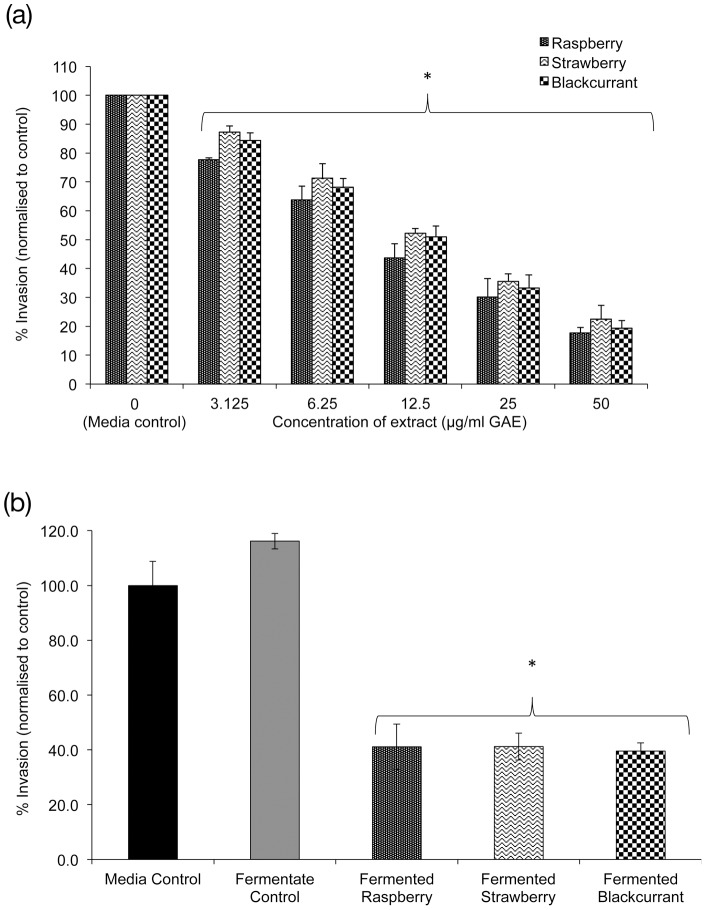
The anti-invasive effects of various types of berry extracts on HT115 cells.(A) Effects of IVD berry extracts, (B) berry fermentates. Mean of 3 independent experiments + SD, One-way ANOVA and Dunnett T test, * p<0.05, significance is compared to media control (0 µg/mL) for A and against control fermentate in B. Values are expressed as % cell invasion normalised to control. Berry extracts had no effect on migration of HT115 cells (data not shown). Phenol levels for berry fermentates were raspberry 15.5, strawberry 13.9, blackcurrant 12.4 µg/mL GAE.